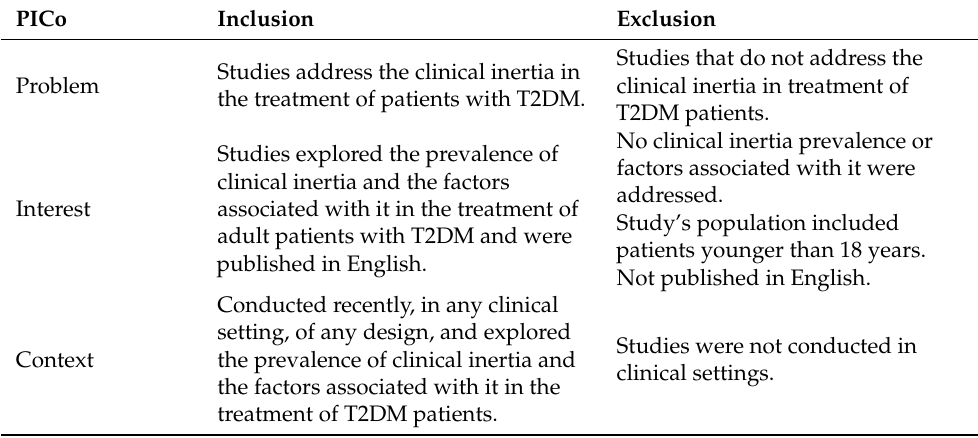
Table 2. Studies’ eligibility criteria based on the PICo